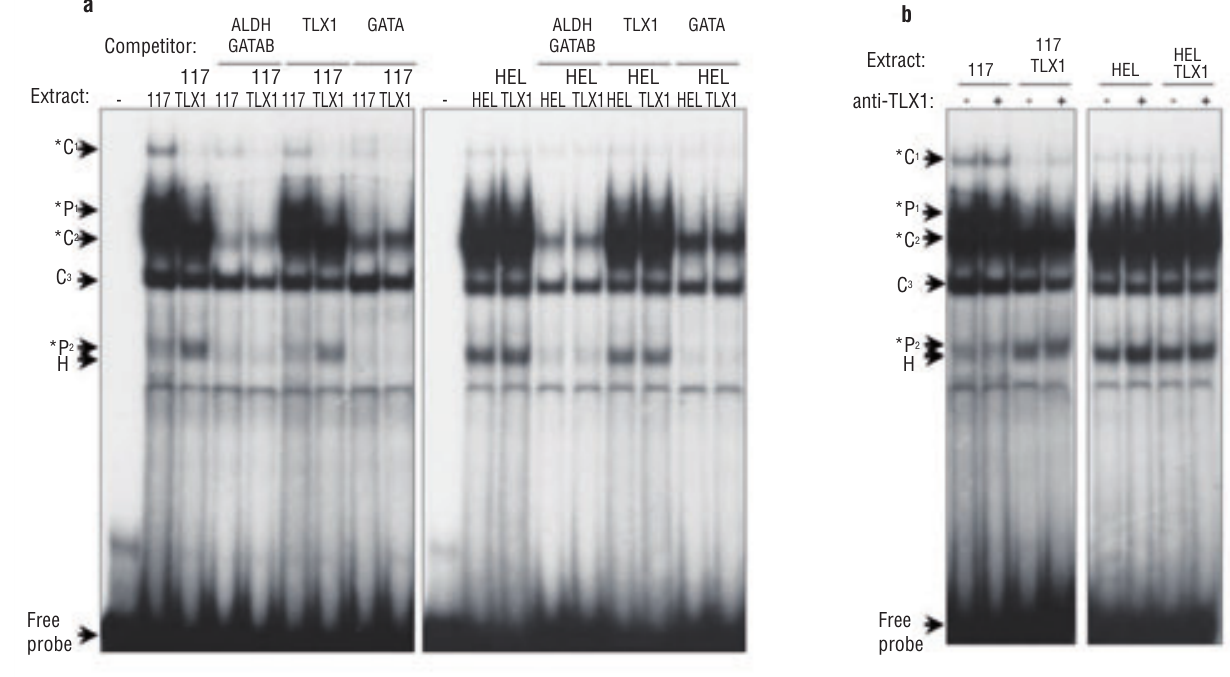
Figure 5. Perturbation of GATA-containing complexes by TLX1. (A) GATA factor(s) but not TLX1 binds to the ALDH1A1 promoter GATA box. EMSA using a 32P-labeled double-stranded oligonucleotide containing the GATAAA site at -33 of the human ALDH1A1 promoter (ALDH GATAB). The assay was performed with nuclear extracts prepared from PER-117 (left panel) or HEL cells (right panel) with and without overexpression of TLX1. The migration of the free probe is indicated along with the positions of specific DNA- protein complexes (C1, C2, P1 and P2 in PER-117 cells; C1, C2 and H in HEL cells). Overbars denote the addition of a 35-fold molar excess of unlabeled double-stranded self (ALDH GATAB), satellite 2 DNA (TLX1) or GATA consensus (GATA) probe as competitor. Asterisks denote complexes altered by TLX1. (B) TLX1 directly disrupts the low mobility ALDH1A1 promoter GATA box complex C1. EMSA performed as above using the -33 GATAAA site oligonucleotide (ALDH GATAB) in the absence (-) or presence (+) of TLX1 anti- body. The migration of the free probe is indicated along with the positions of specific DNA-protein complexes (C1, C2, P1 and P2 in PER-117 cells; C1, C2 and H in HEL cells). Complex C1 reappears in PER-117 cells expressing TLX1 in the presence of anti-TLX1 antibody